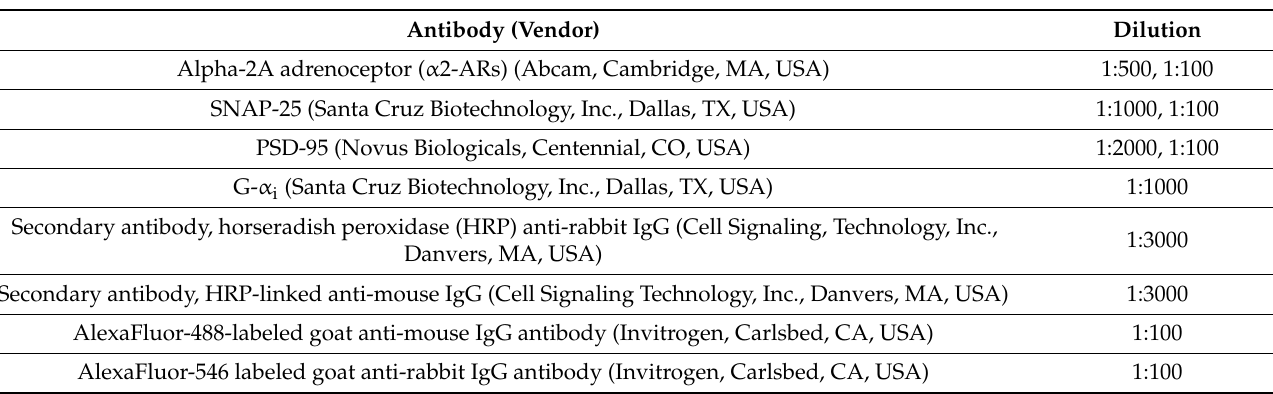
Table 1. Antibodies used in the study. Antibody (Vendor)